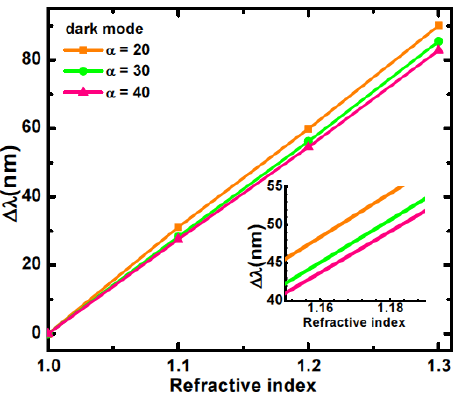
Figure 6. Dark mode resonance wavelength shift as a function of refractive index for length asymmetry α = 20, 30 and 40 nm